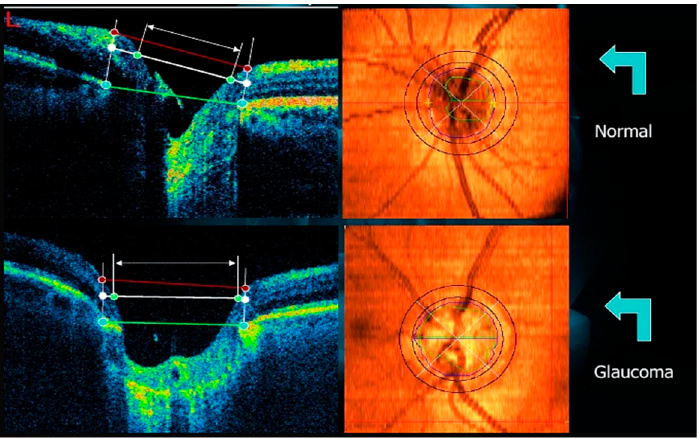
Figure 1. Example of an OCT scan.